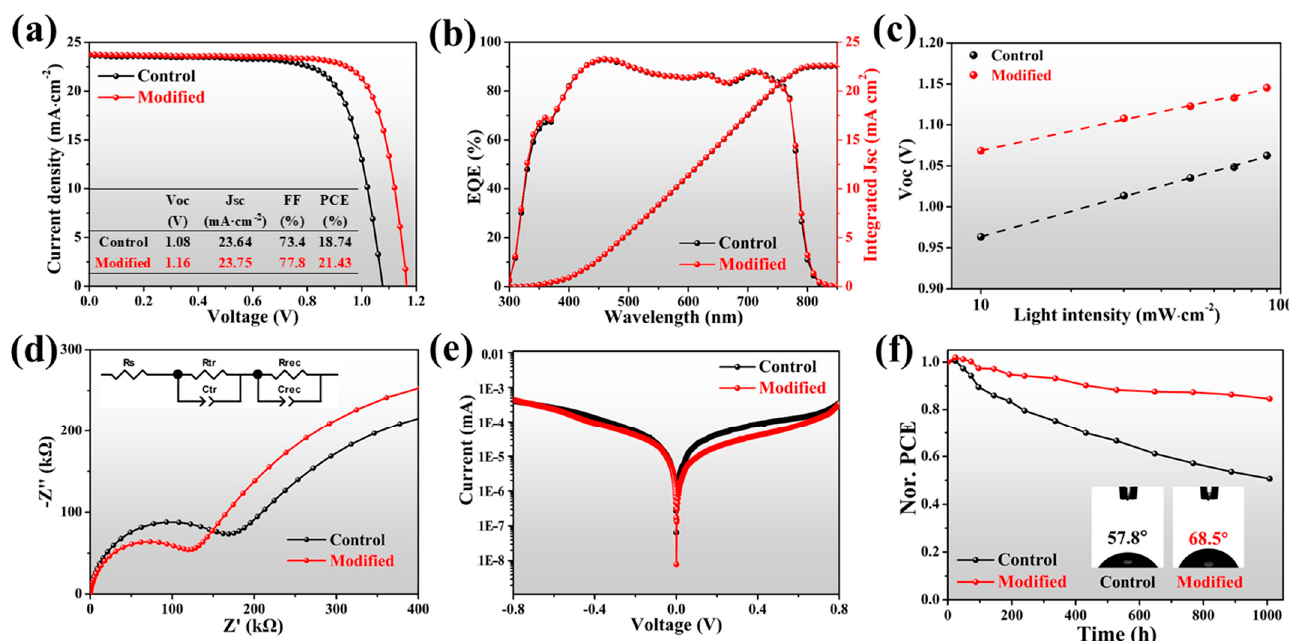
Figure 4. ( a ) Forward-scanning J-V curves of the control and modified devices under simulated AM 1.5 G illumination of 100 mW ∙ cm − 2 . ( b ) EQE spectra and ( c ) light-intensity-dependent V oc curves of PSCs. ( d ) Nyquist plots and ( e ) dark current leakage curves of PSCs. ( f ) long-term stability of normalized PCE of unencapsulated PSCs aged at ambient conditions; insets: water contact angles for control and modified.